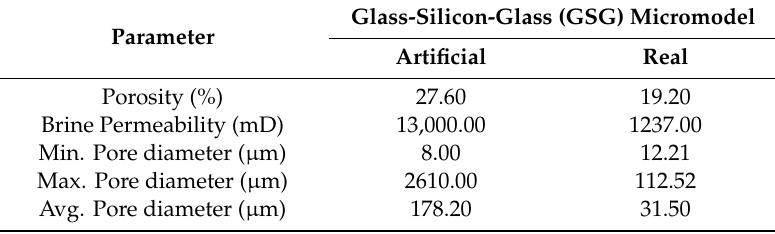
Table 4. Description of micromodels according wettability approach.